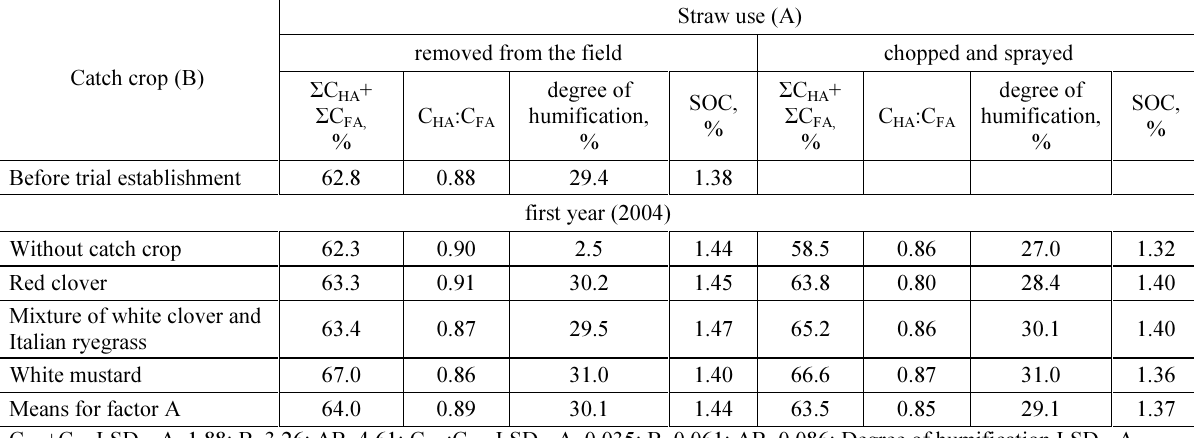
Table 4. Change of organic carbon and humic matter in the soil (0–25 cm) after catch crop biomass and straw incorporation Straw use (A) removed from the field chopped and sprayed Catch crop (B) ΣC HA + ΣC